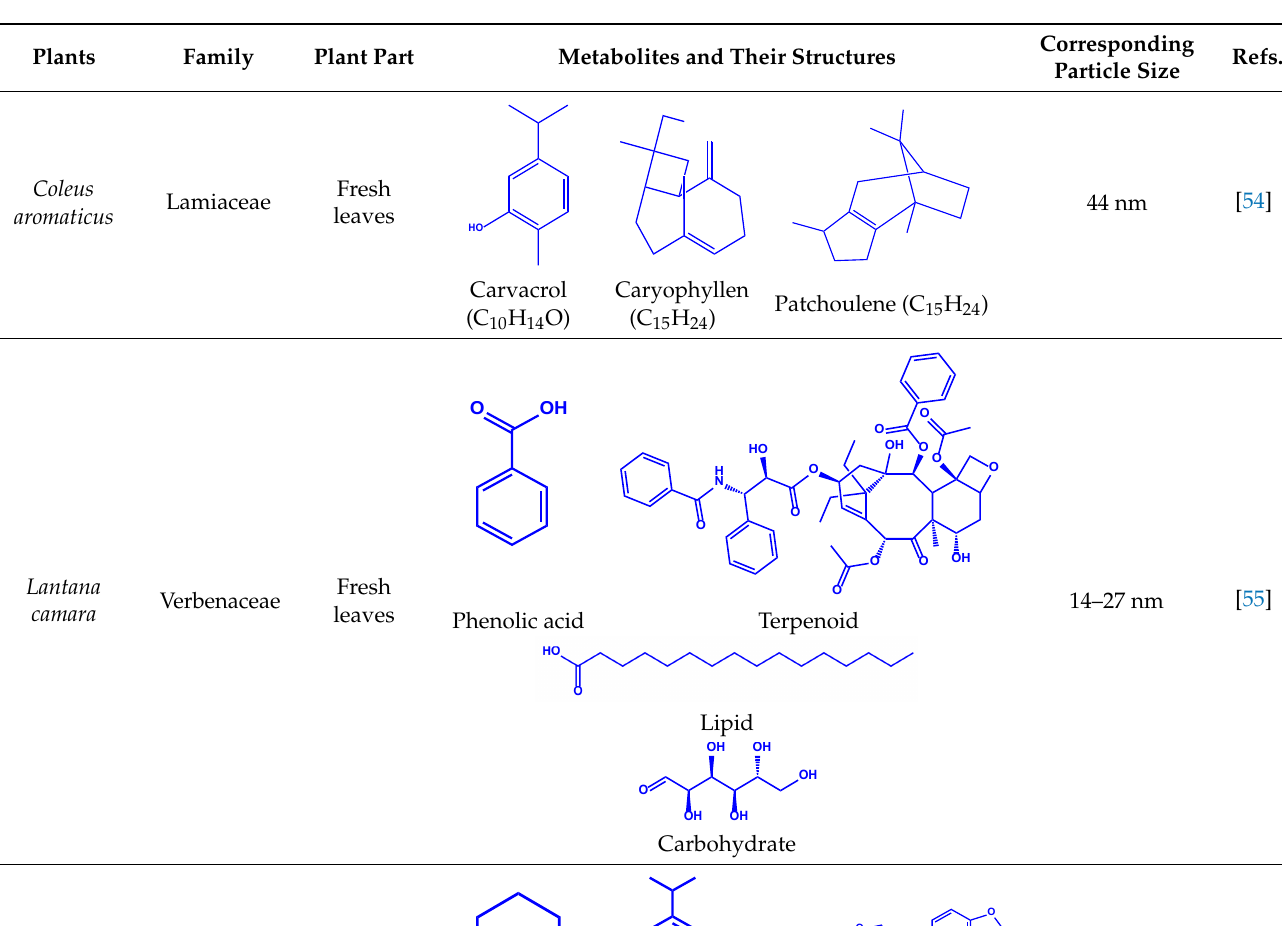
Corresponding Particle Size